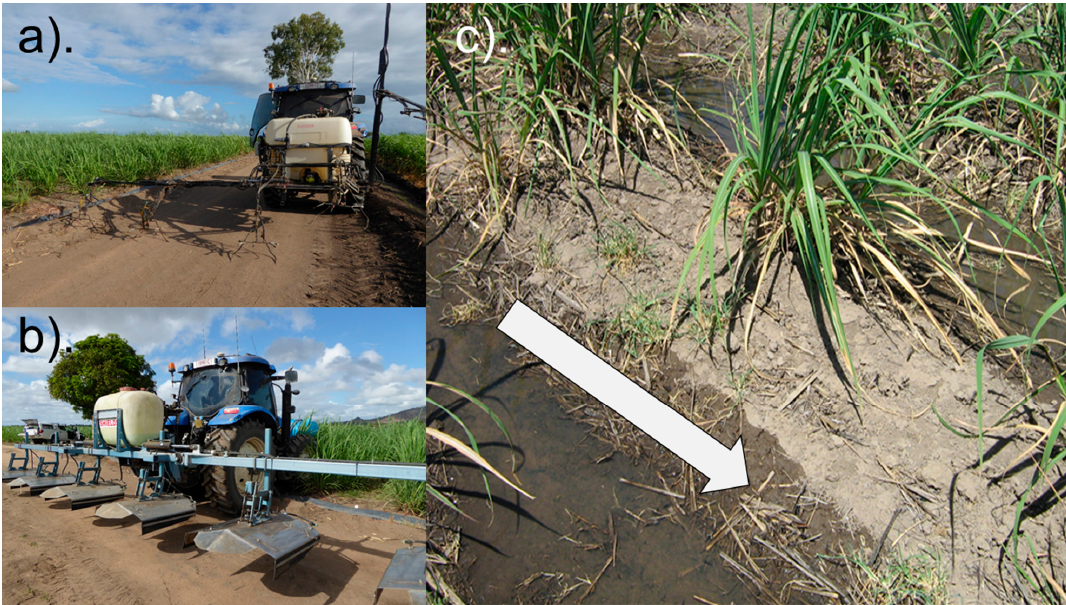
Figure 2. ( a ) A conventional Irvin-leg boom sprayer widely used across GBR sugarcane growing for broadcast herbicide application across the entire paddock, where the herbicide spray covers the entire paddock area below the canopy (‘blanket coverage’), and ( b ) a shielded dual herbicide sprayer for precision, banded herbicide application. Note the hood, which restricts some herbicide applications to inter-row (furrow) where irrigation water flows. ( c ) Applied irrigation water moving down paddock inter-row during the monitored furrow irrigation event, highlighting minimal water contact with raised row (with cane), where pre-emergent herbicides are applied during precision band spraying. Arrow indicates direction of water flow down furrows (inter-row).